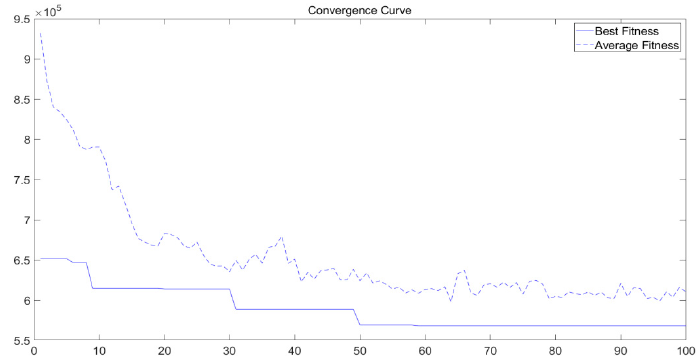
Figure 5. Convergence of the immune algorithm.